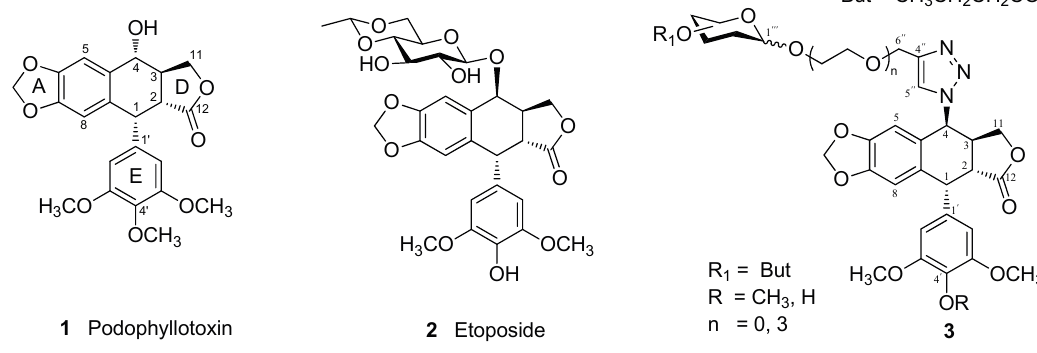
Figure 1. Structures of podophyllotoxin ( 1 ), etoposide ( 2 ) and podophyllotoxin derivatives ( 3